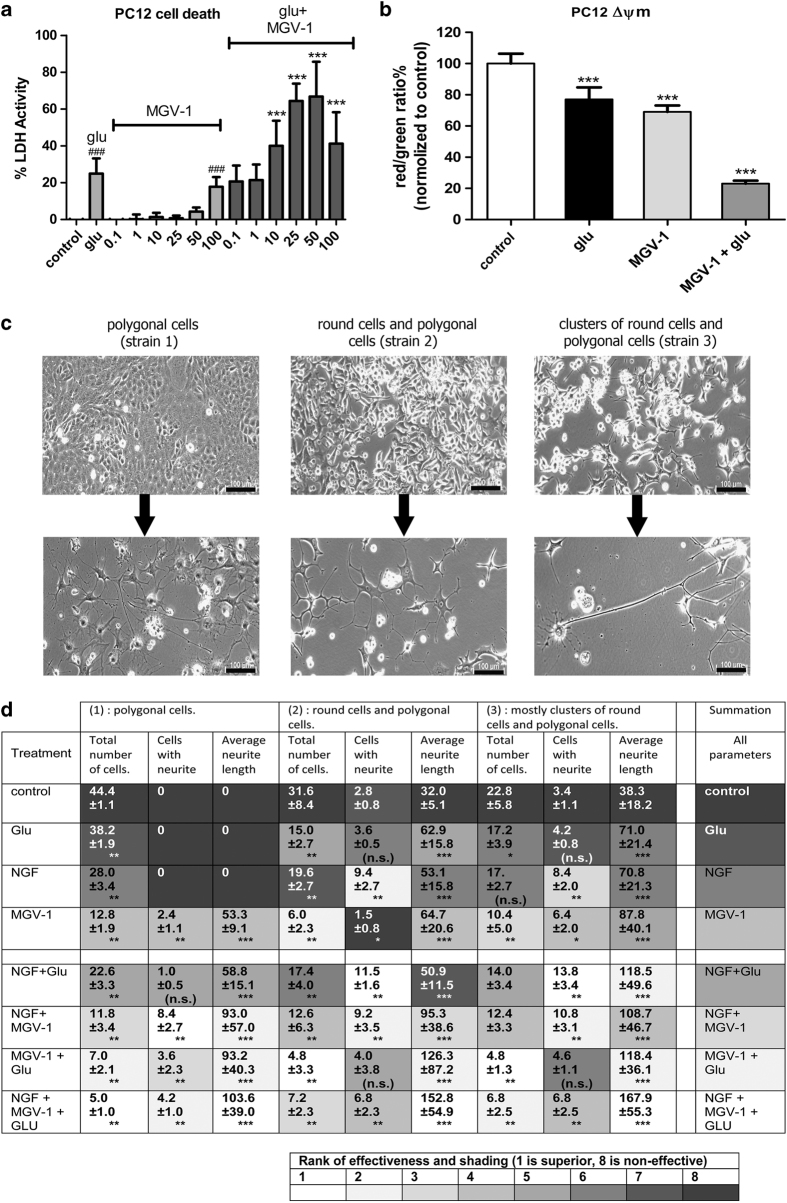
Effects of MGV-1 (and NGF and glutamate, as well as the various combinations of these three compounds) on PC12 cells regarding viability and differentiation. (a) As opposed to U118MG cells, together with 35 mM of glutamate, MGV-1 (10, 25, 50, 100 μM as indicated at the x axis) induces enhanced cell death of PC12 cells, as compared with application of 35 mM of glutamate by itself. At 100 μM, MGV-1 by itself can induce cell death of PC12 cells. (b) Separately and synergistically, MGV-1 (50 μM) and glutamate (35 mM) induce collapse of the ΔΨm in PC12 cells. (c) Representative examples of different PC12 cell strains (see Materials and methods section): strain #1 (only flat, attached polygonal cells), strain #2 (round cells and polygonal cells), and strain #3 (floating clusters of round cells and a restricted number polygonal cells). MGV-1 can induce differentiation of various strains of PC12 cells. The top row of this c presents undifferentiated cells, and the bottom row of the c presents typical examples of differentiated cells of the three strains. As the morphologies of the undifferentiated cells of the three strains are different, the morphologies of these cell strains differentiated by our applications are also distinct. Neurite sprouting from strain #1 makes the cells appear star shaped (here differentiated by MGV-1+glutamate). Strain #2 gives rise to extended thin neurites (here differentiated by MGV-1+glutamate). Strain (3) gives rise to very long thin neurites (here differentiated by MGV-1+NGF). (d) Table: MGV-1, NGF, and glutamate, separately and combined, can induce neurodifferentiation of strains of PC12 cells presenting both spherical and polygonal cells (strains 2 and 3). The lower the total number of cells, the more the cells are differentiated (differentiated cells do not proliferate). The higher the number of cells with neurite (the hallmark of differentiation), the more the cells are differentiated. The longer the average neurite length, the more the cells are differentiated. The strain presenting only polygonal cells (strain #1), can be differentiated by MGV-1 by itself, whereas NGF and glutamate by themselves do not have this effect on cells of strain #1 (as demonstrated as 0 cells presenting a neurite, that is, neurites of 0 length). The shading in the Table for all treatments is according to rank each time in one column (see ‘key’ giving the shading for each of the 8 ranks). The murkiest shading for each parameter (total number of cells, cells with neurite, average neurite length) presents the lowest indication of differentiation (typically the control), the brightest shading indicates the most effective differentiation. Summing up the ranks of each row (presented in the most right-hand column) it was found, looking at the individual treatments of Glu, NGF, and MGV-1, that: MGV-1 works better than NGF works better than glutamate. Interestingly, measuring the percentages of differentiated cells as part of the total cell population remaining per plate, gives the exact same rank order of effectiveness. Regarding combinations of molecules: (MGV-1+Glu+NGF) works better than (MGV-1+Glu) works better than (MGV-1+NGF) works better than (NGF+Glu). Looking at each cell type regarding capacity of differentiation (comparing each parameter for each cell strain and each treatment), the rank order of capacity to differentiate is: Strain #3>Strain #2>Strain #1. Statistical significance following one-way ANOVA and post hoc Mann–Whitney: *P<0.05; **P<0.01; ***P<0.001. The scale bars in c are 100 μM.